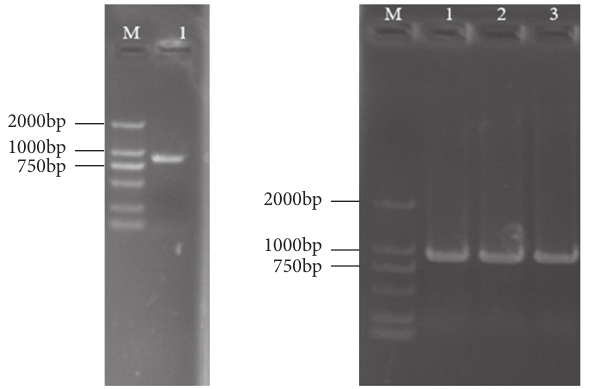
Figure 1: PCR amplification and PCR